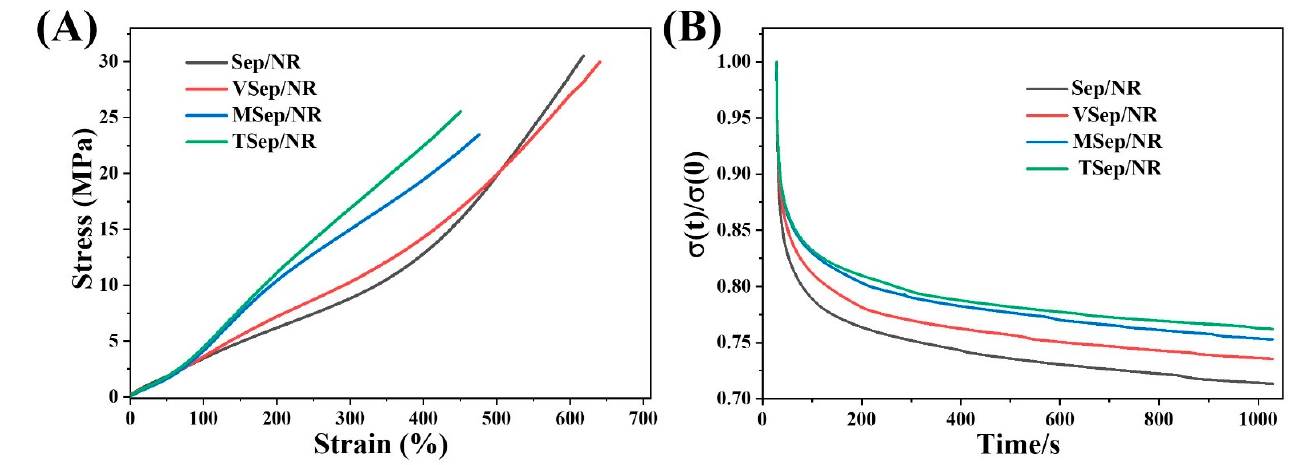
Figure 9. ( A ) The stress–strain curves of sepiolite/NR vulcanized composites, and ( B ) stress relaxation curves normalized with respect to the initial stress for vulcanizates (applied strain 100%). Table 5. Static mechanical properties of sepiolite/NR composites.